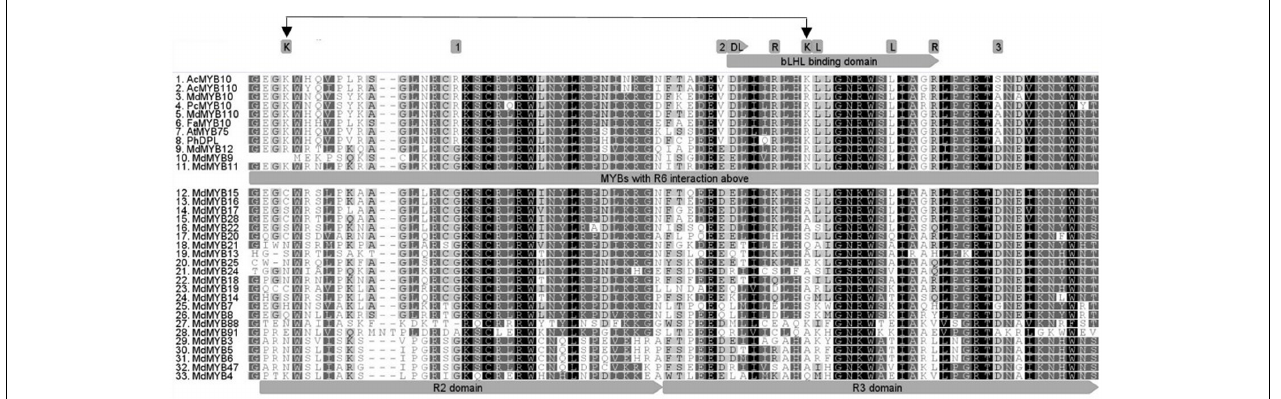
FIGURE 3 | Deduced amino acid sequences were aligned using CLUSTALW. The bHLH binding region within the R3 domain is indicated (gray arrow) and conserved amino acids required for the bHLH-dependant activation (Grotewold et al., 2000) are highlighted above it. Box 1, 2, and 3 show previously described conserved residues specific to dicot anthocyanin-promoting MYBs (Lin-Wang et al., 2010). Double black arrow indicates the signature (K/R) 25 -(X)x46-(K/R/N) 72 specific to the R6-activating MYBs.